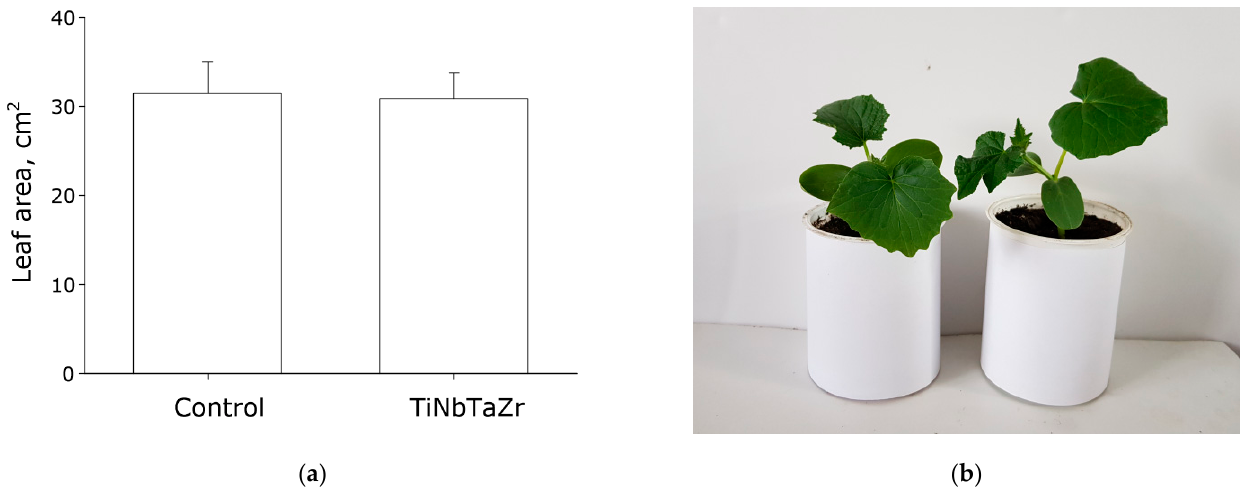
Figure 6. Ti-20Nb-10Ta-5Zr influence on plant growth: ( a ) average values Solanum lycopersicum leaf areas; ( b ) photos of Cucumis sativus plants (left—control, right—Ti-20Nb-10Ta-5Zr alloy).